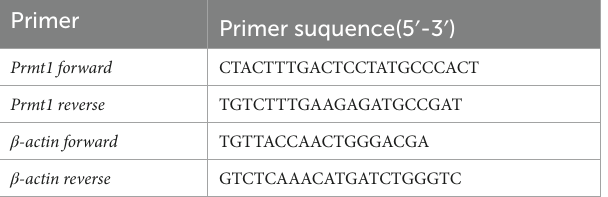
TABLE 1 Primer sequences for real-time quantitative fluorescence PCR. Primer